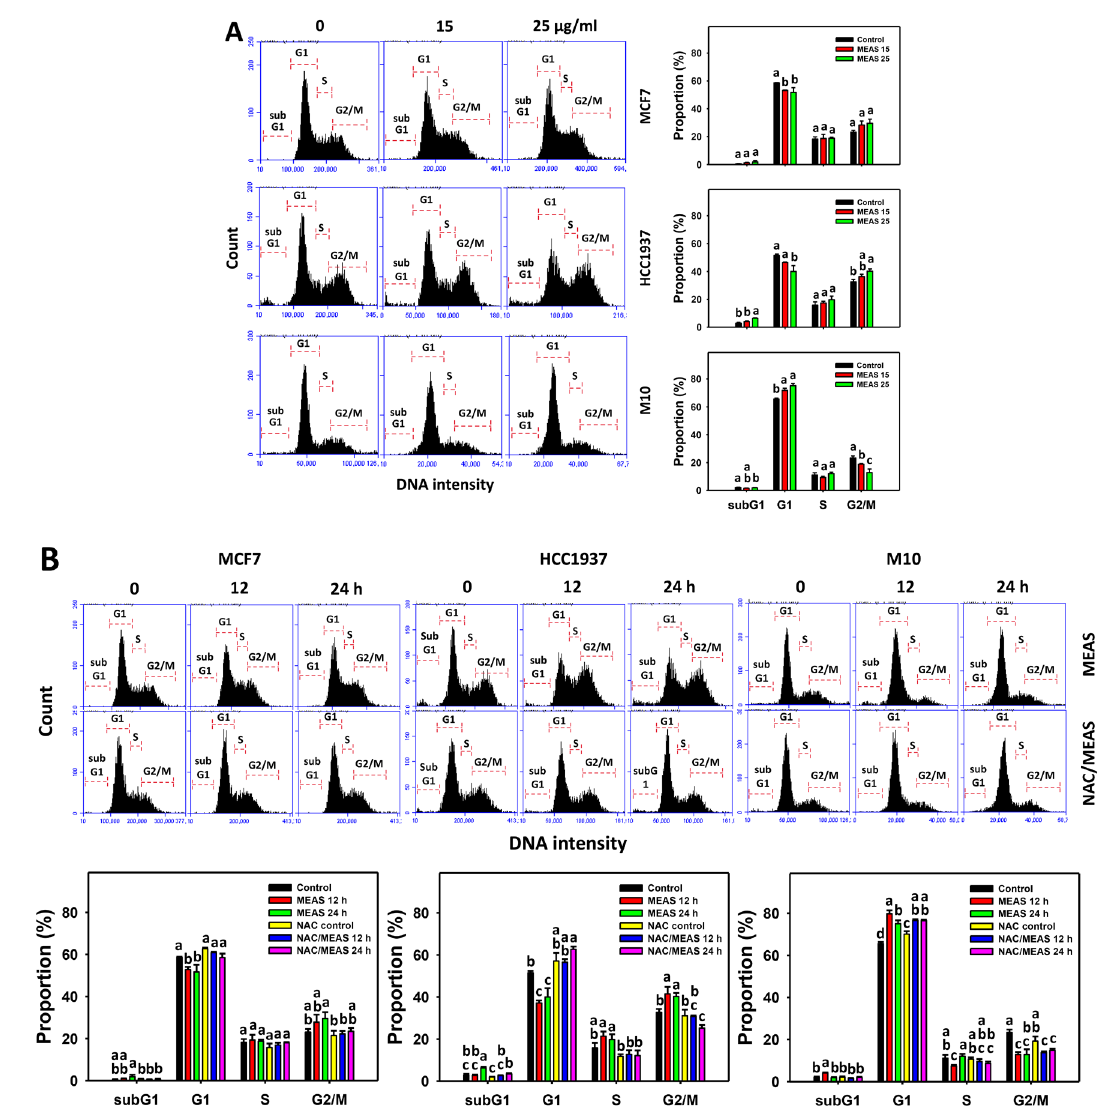
Figure 3. MEAS causes cell cycle redistribution of breast cancer cells. ( A ) Cell cycle assay of MEAS. Except for normal breast cells (M10), others were TNBC and non-TNBC cells. Flow cytometry was performed after 24 h drug treatment. ( B ) Cell cycle assay of NAC/MEAS. NAC/MEAS represents NAC pretreatment (10 mM, 1 h) and MEAS posttreatment for 0, 12, and 24 h. Data = mean ± SD ( n = 3). Statistical software assigned low-case letters to each treatment. When the letters of different treatments overlapped, the results were significant ( p < 0.05).